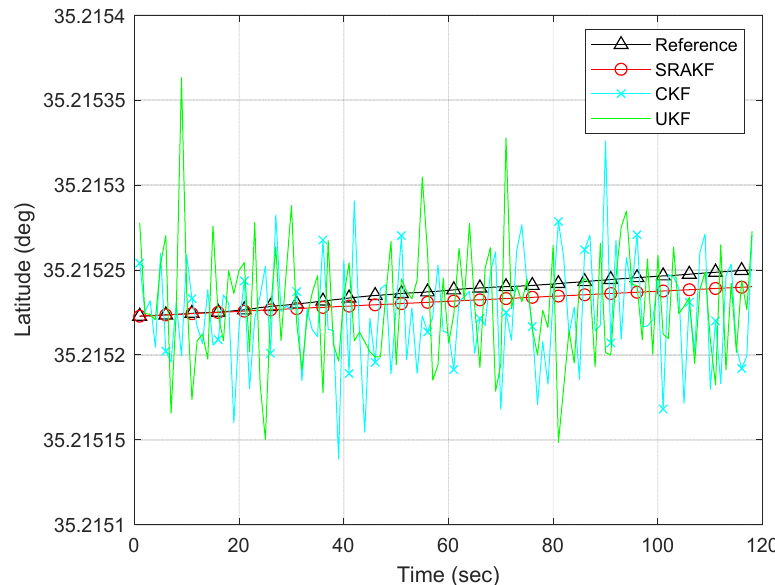
Figure 15. Latitude positions for the robustness lake trial.